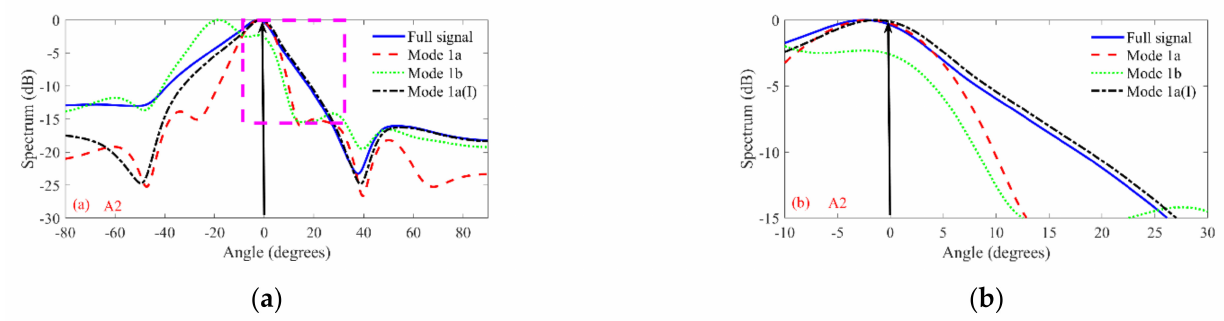
Figure 6. ( a ) Estimation results of the source bearing at point A2 with array L2, using the full signal, the direct and the refracted paths of mode 1, and the first packet signal of the direct path of mode 1; ( b ) a zooming-in of the area enclosed by the dashed square in ( a ). The true azimuth of the sound source is indicated by the black vertical solid